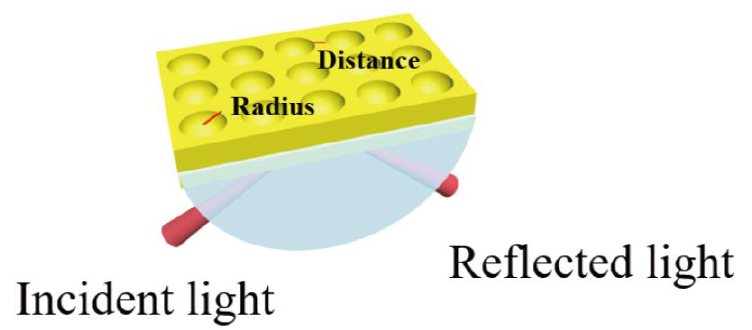
Figure 6. Schematic diagram of the Au array structure SPR sensors.